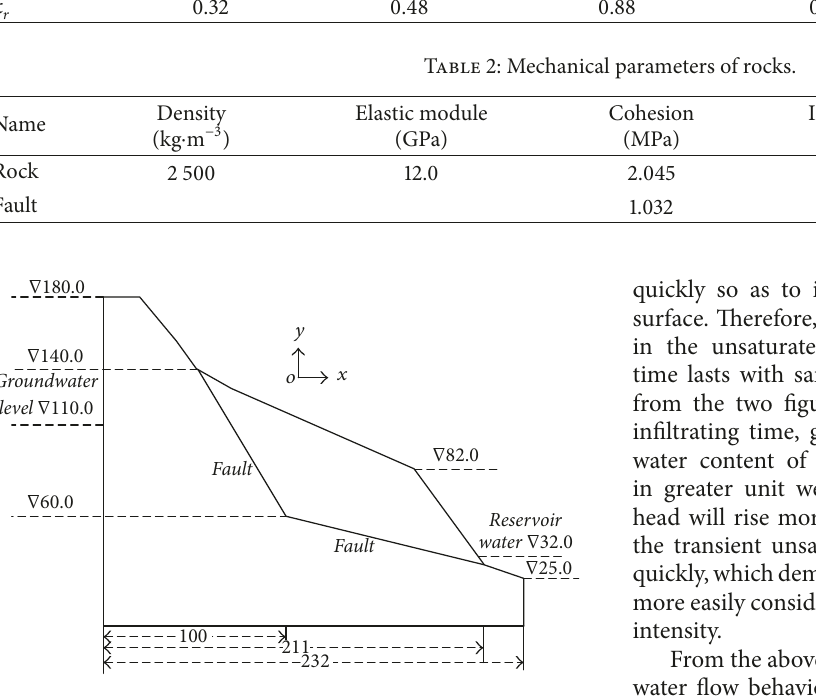
Figure 7: Diagram of a rock slope (unit: